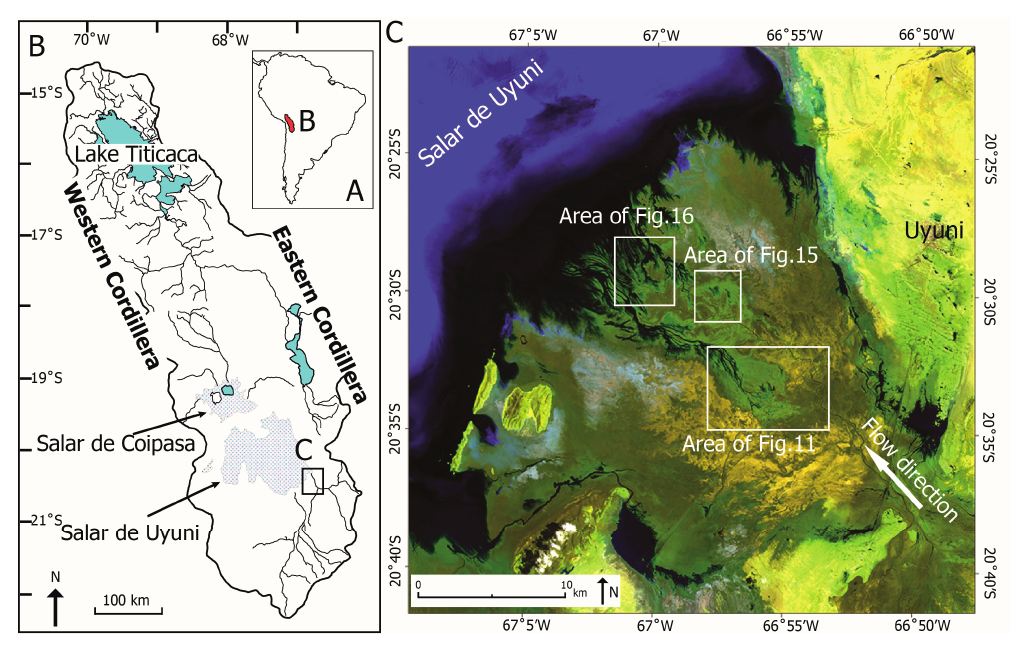
Figure 1. Map of the study area. ( A , B ) The location of Altiplano plateau in South America (modified from [29]). ( C ) A false-color image of Landsat Thematic Mapper (TM) with bands 7 (red), 5 (green) and 1 (blue) on 24 February 2006 indicating the study